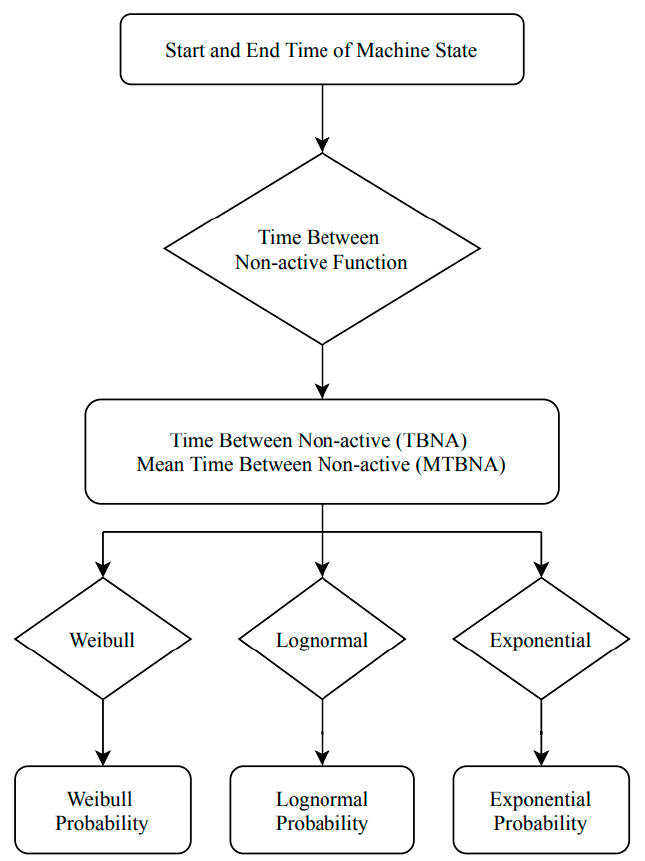
Figure 2. Structure of feature extraction in reliability analysis.